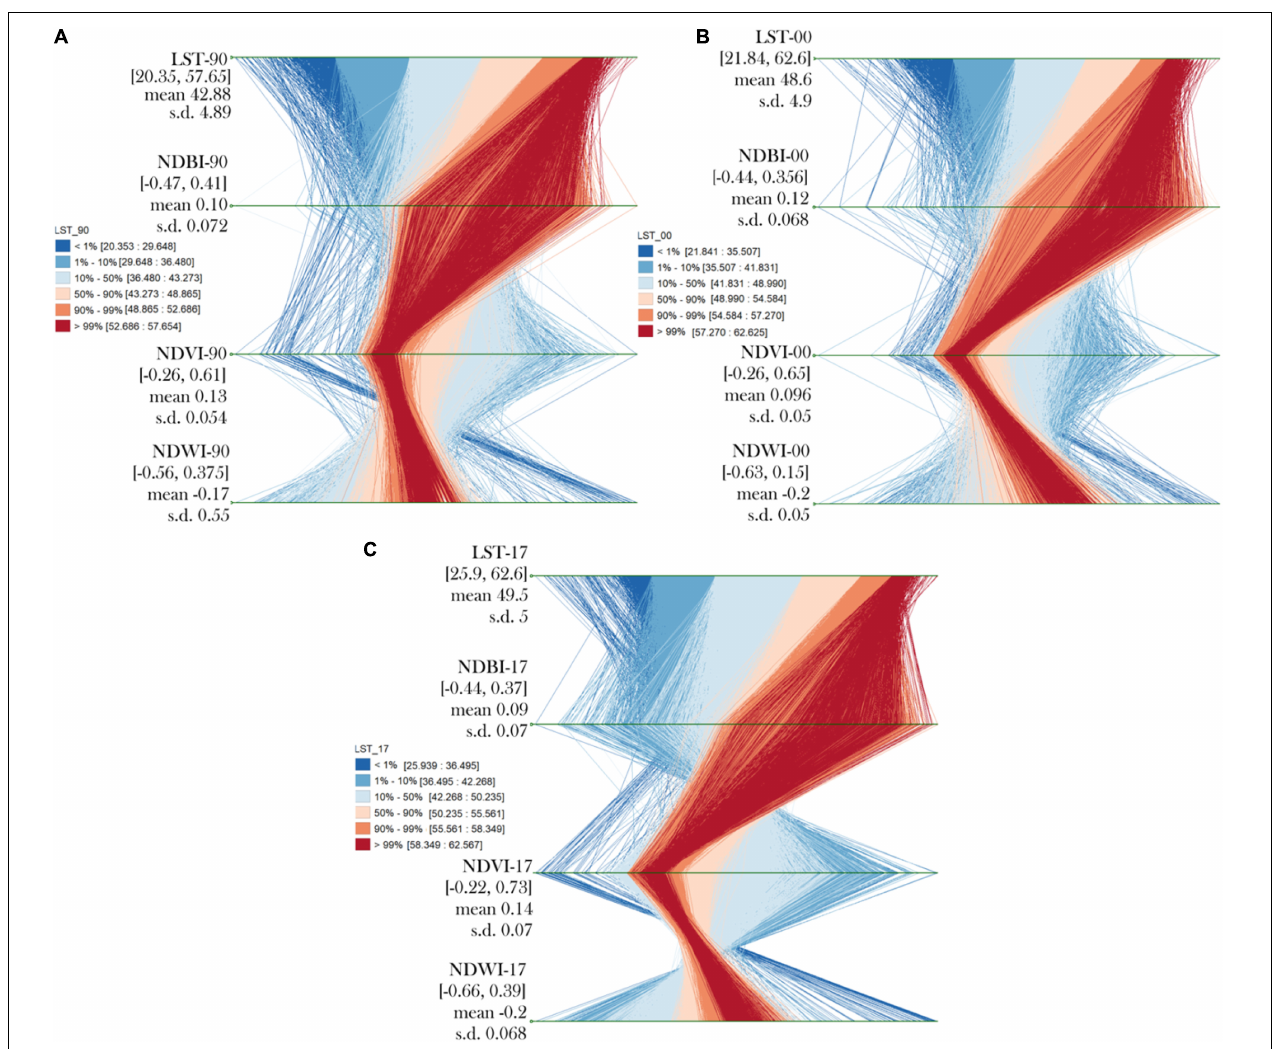
FIGURE 6 | Parallel coordinate plot for establishing relationship between LST and urban biophysical parameters for the year (A) 1990, (B) 2000, and (C)